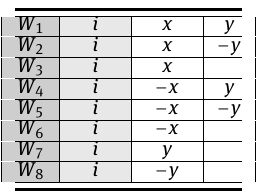
Table 2. Partial index distribution of the codewords of G i .